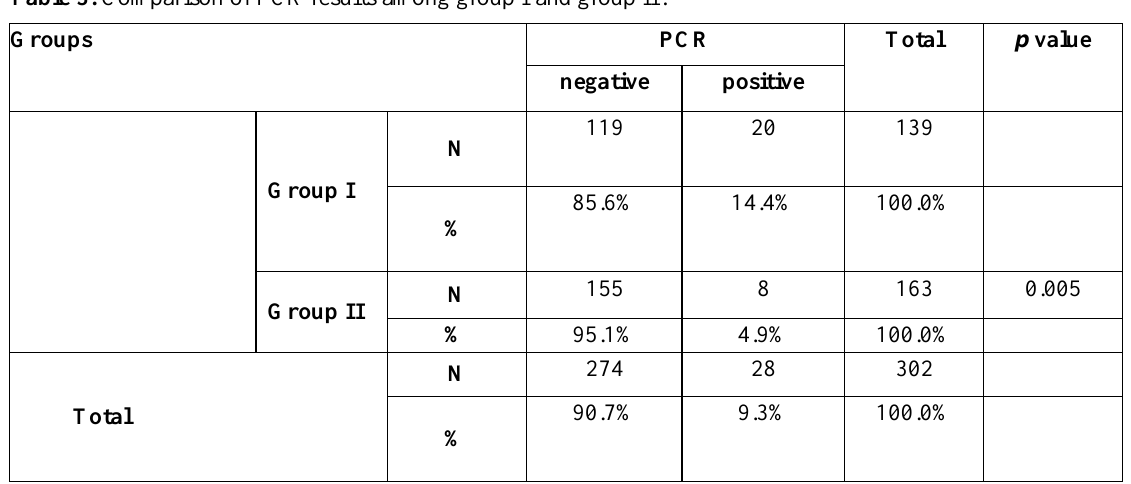
Table 3. Comparison of PCR results among group I and group